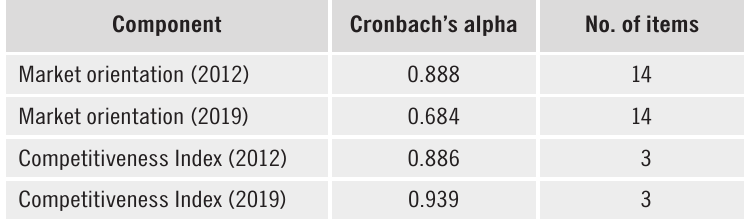
Table 6. Results of Cronbach’s alpha reliability